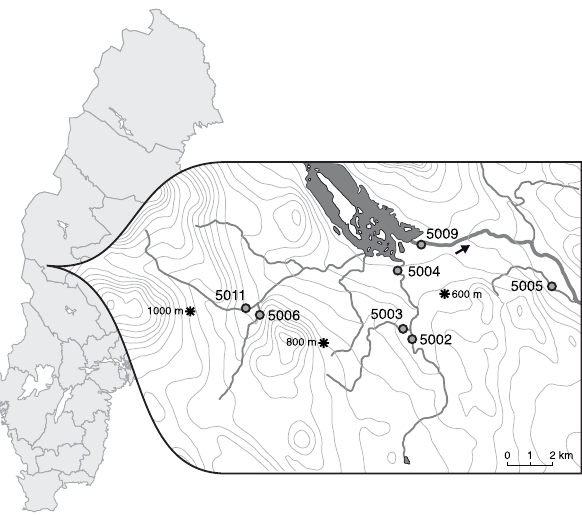
Fig. 1. Location and map of the study area with the stream-sampling stations and snowpack sites marked out. The snow sampling station at 400ma.s.l. is outside the map about 40km to the